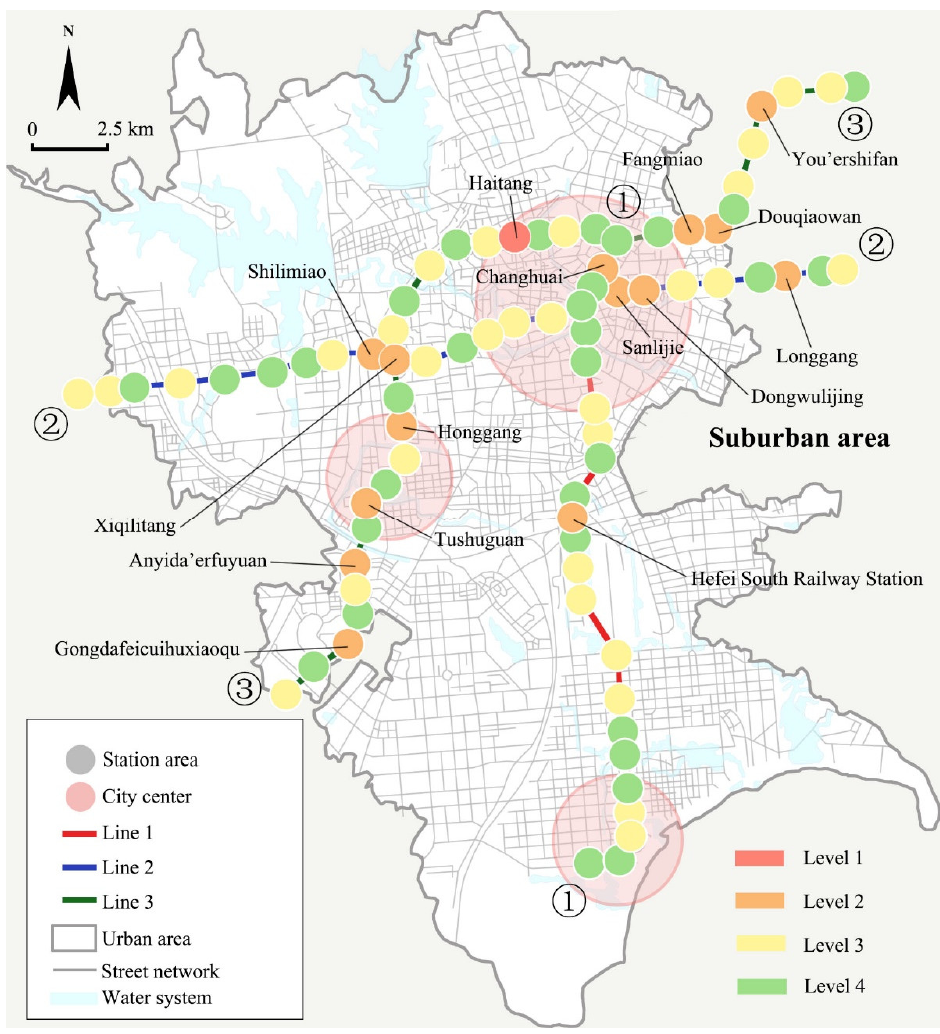
Figure 8. Map of the distribution of 15 priority TODs in Hefei City. Table 3. ( a ) Detailed description of 15 priority TODs (node-value). ( b ) Detailed description of 15 priority TODs (place-value).